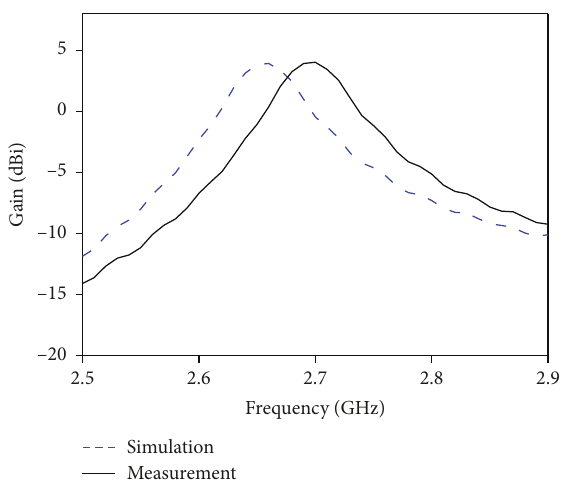
Figure 7: Simulated and measured radiation gain of the proposed MA.